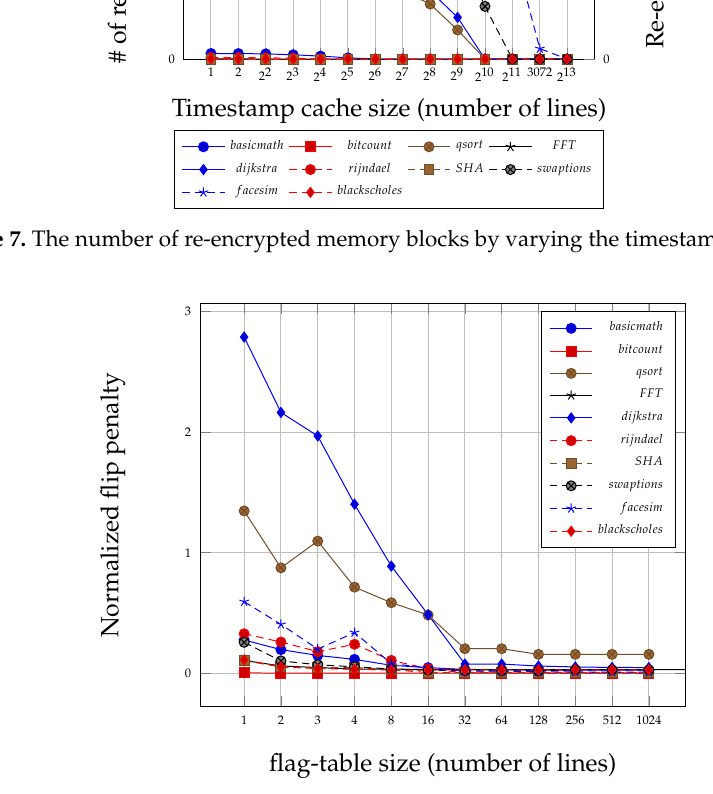
Figure 8. Normalized flip penalty with varying flag-table